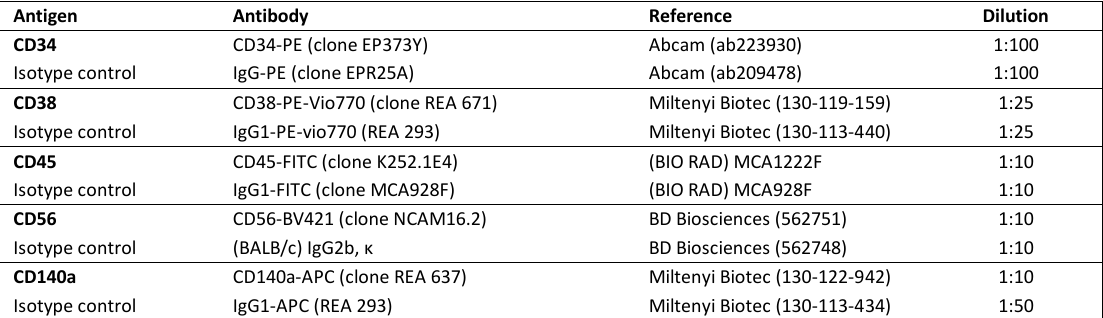
Table 1. List of antibodies used for flow cytometry